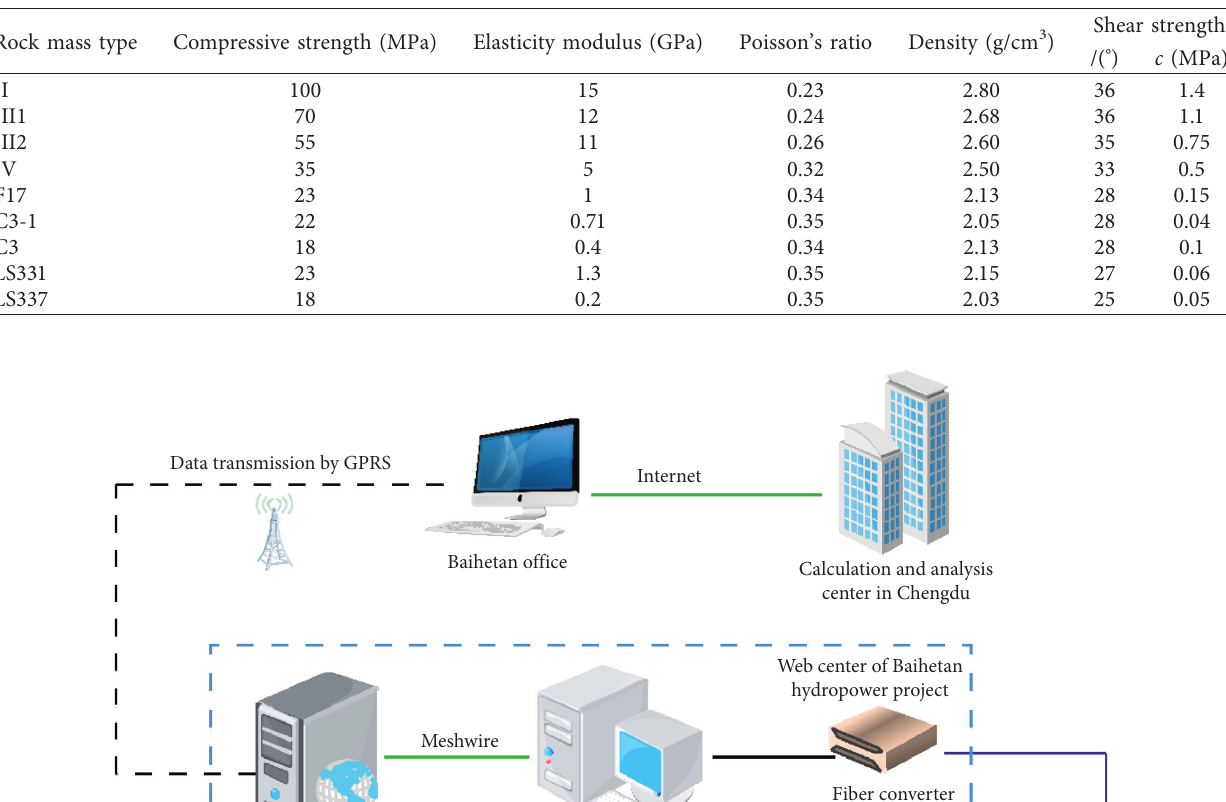
Table 1: Mechanical properties of the main rock masses and weak structural planes.